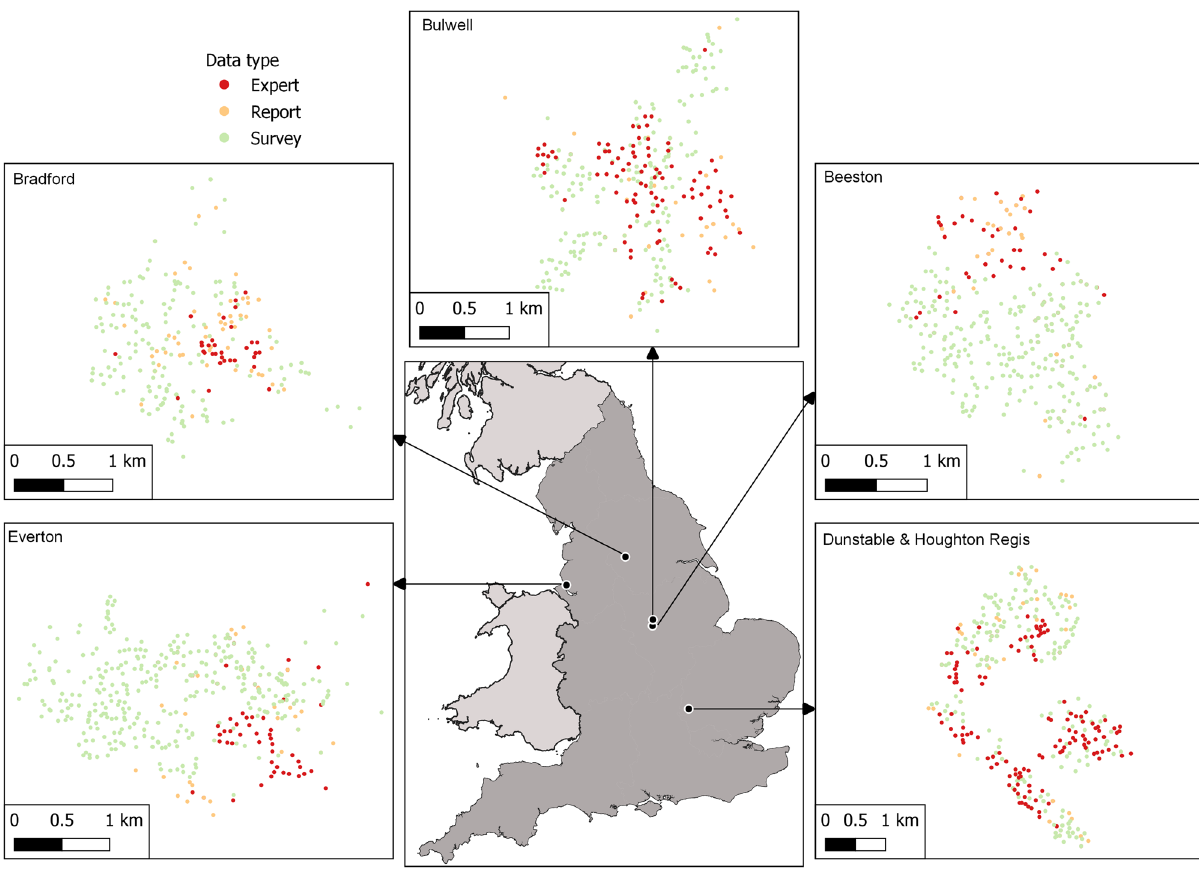
Figure 1. The location of our unowned cat records. Five key study areas in England and geographical distribution of data types within the study regions. Map was generated using QGIS 3.16 (https:// www. qgis.